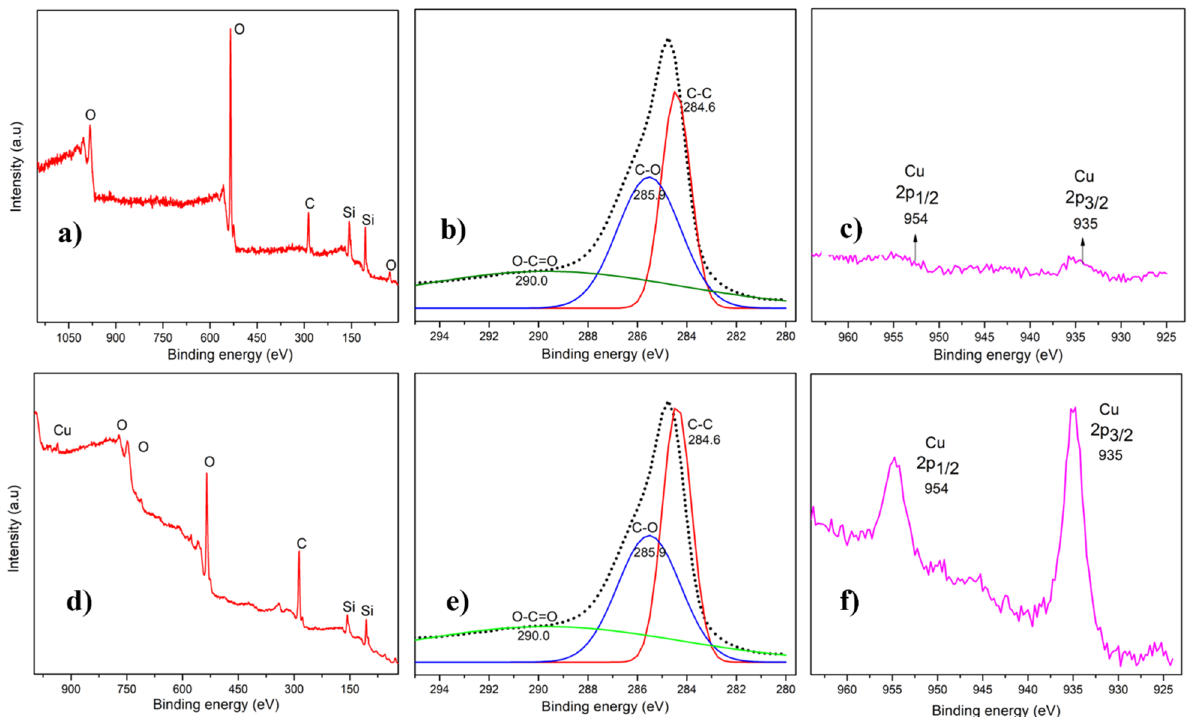
Figure 7. XPS measurements of the graphene growth on SiO 2 /Si substrate: ( a ) shows the XPS full composition spectra, ( b ) carbon peak after deconvolution and ( c ) the copper peaks taken next to the copper-strip. Then ( d – f ) represent the same but on top of the